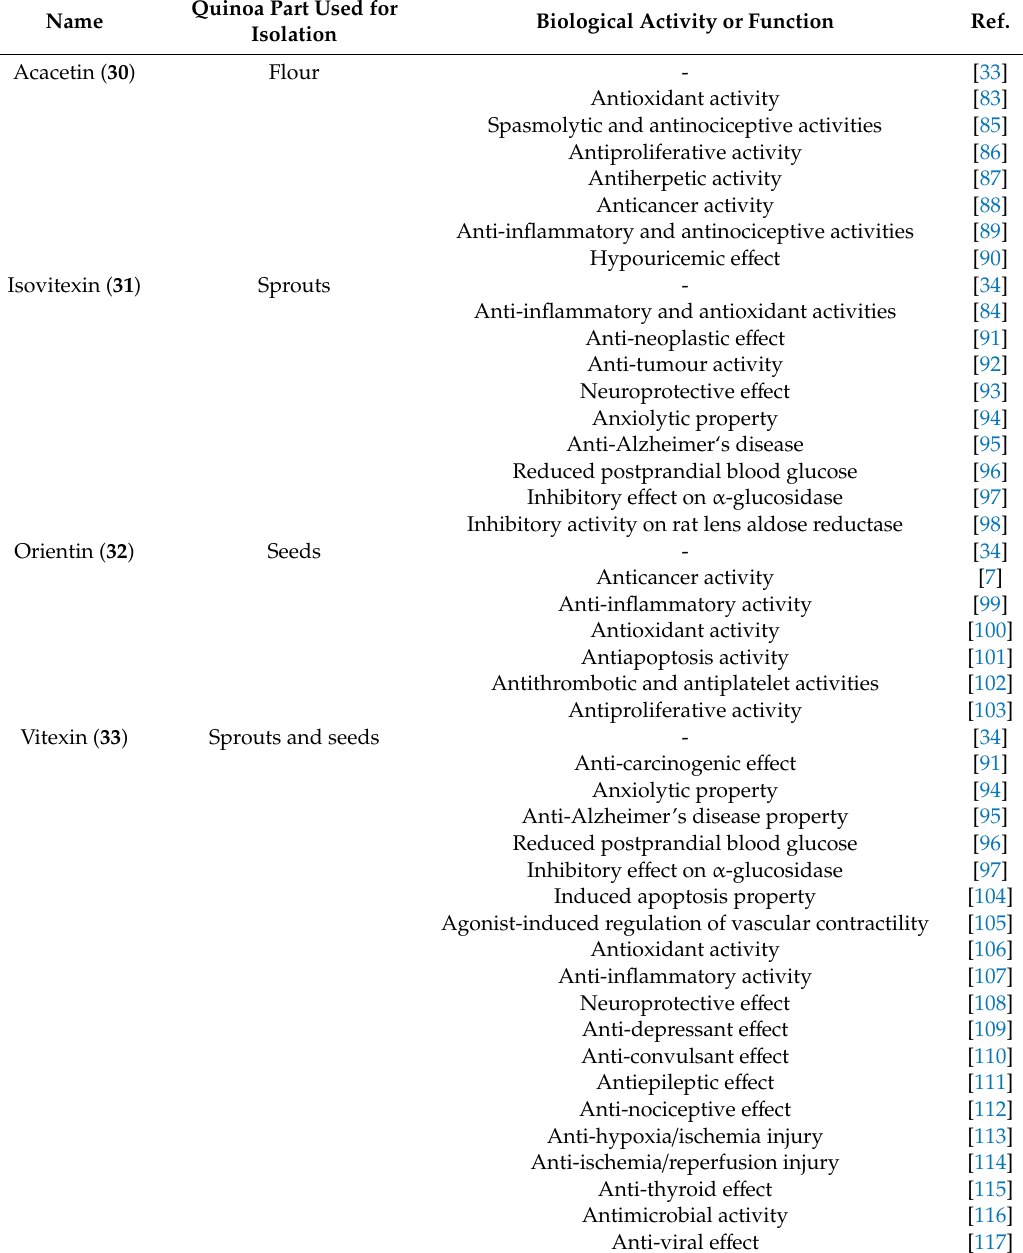
Table 3. Flavones and their biological activities or